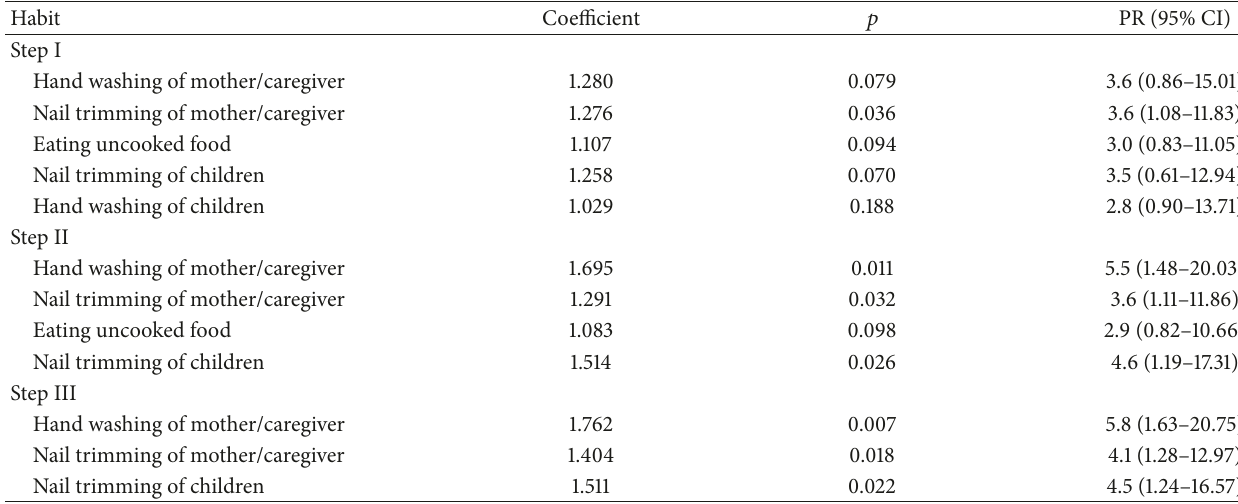
Table 4: The result of multivariate analysis multiple logistic regression for STH infection in preschool